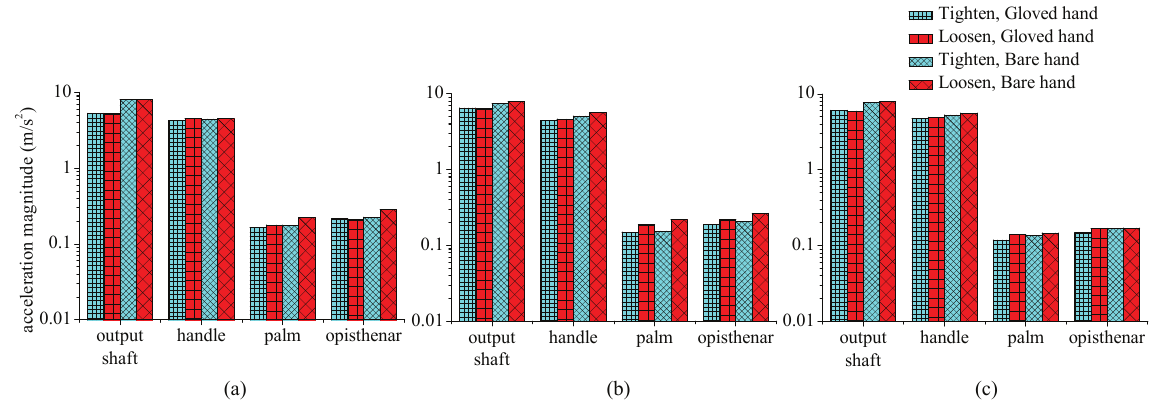
Figure 5. Comparison of mean vibration total value of four measuring points for PPT: ( a ) 400 mm operating rod; ( b ) 300 mm operating rod; and ( c ) 200 mm operating